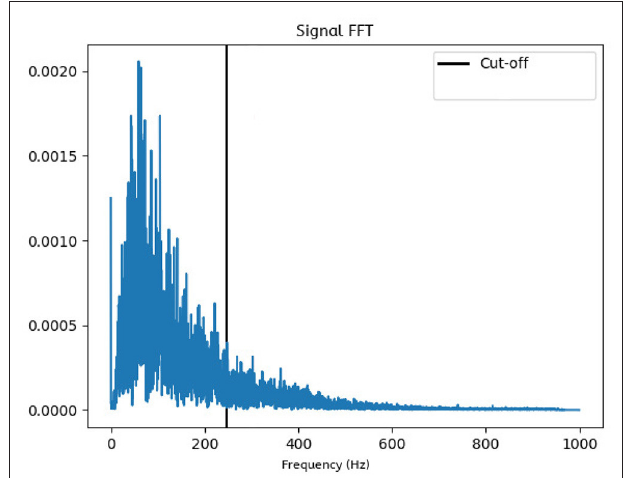
FIGURE 5 | Frequency domain plot: The FFT-generated data is averaged over all trials, which shows that the most prominent frequencies lie within the lower end of the spectrum. All frequencies higher than the computed cut-off point will be ignored in further analysis.